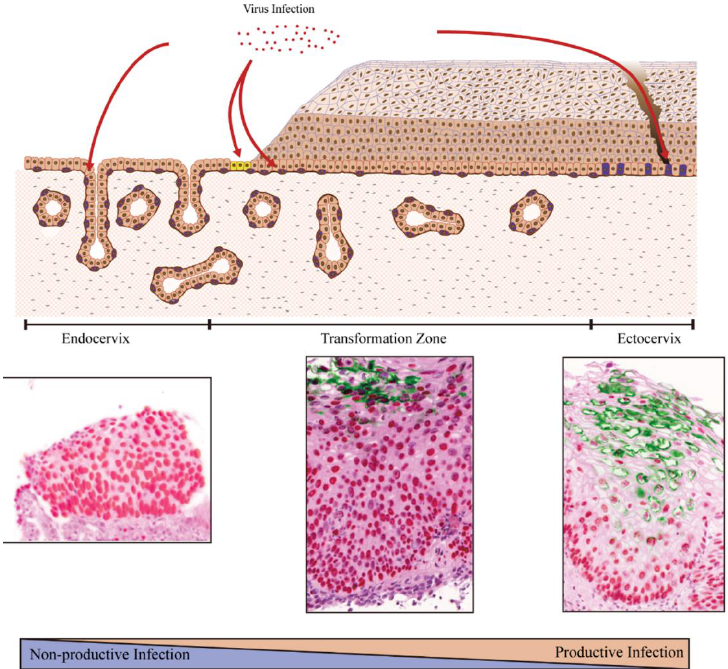
Figure 5. The difference of host cells (the site of infection) affects viral pathogenicity.